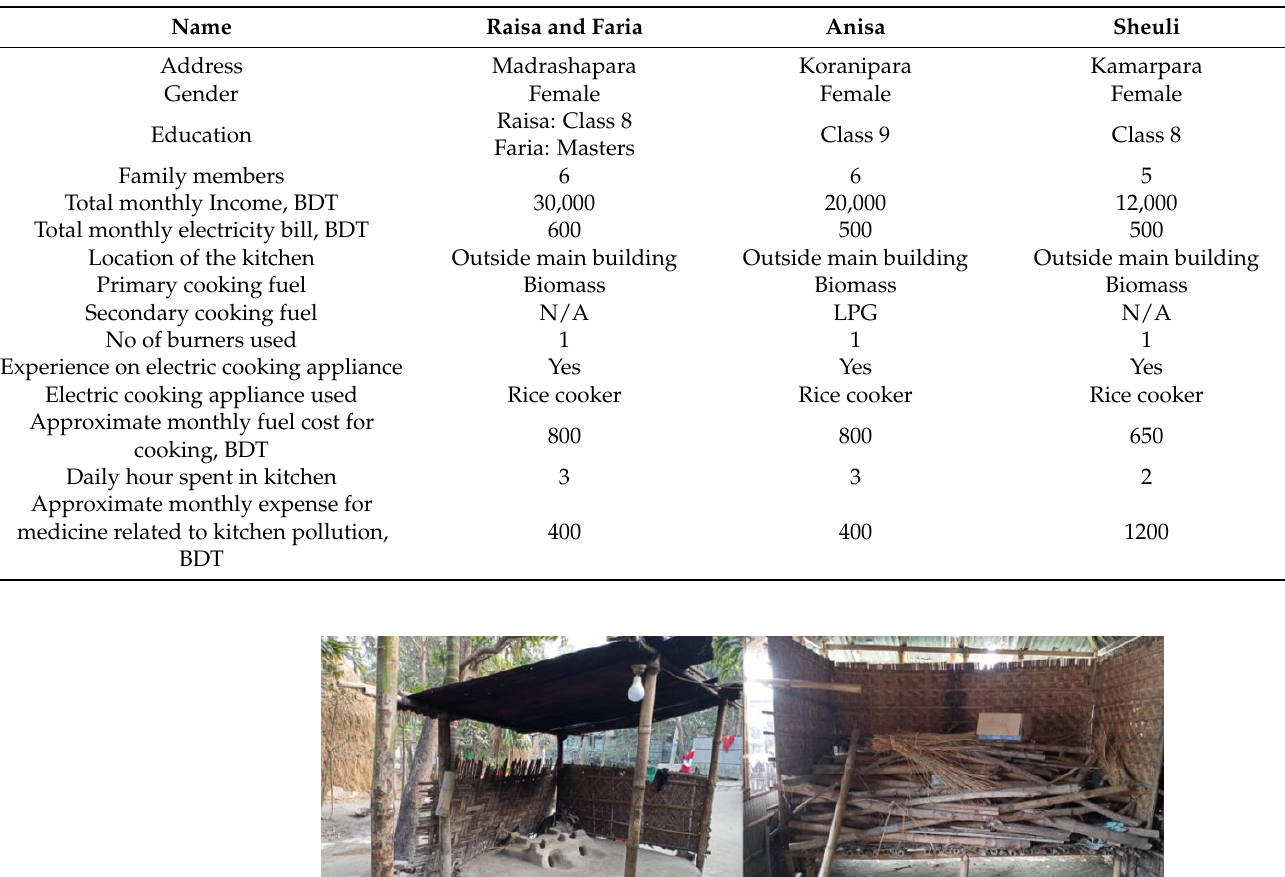
Table 1. Basic information about the households chosen for study.